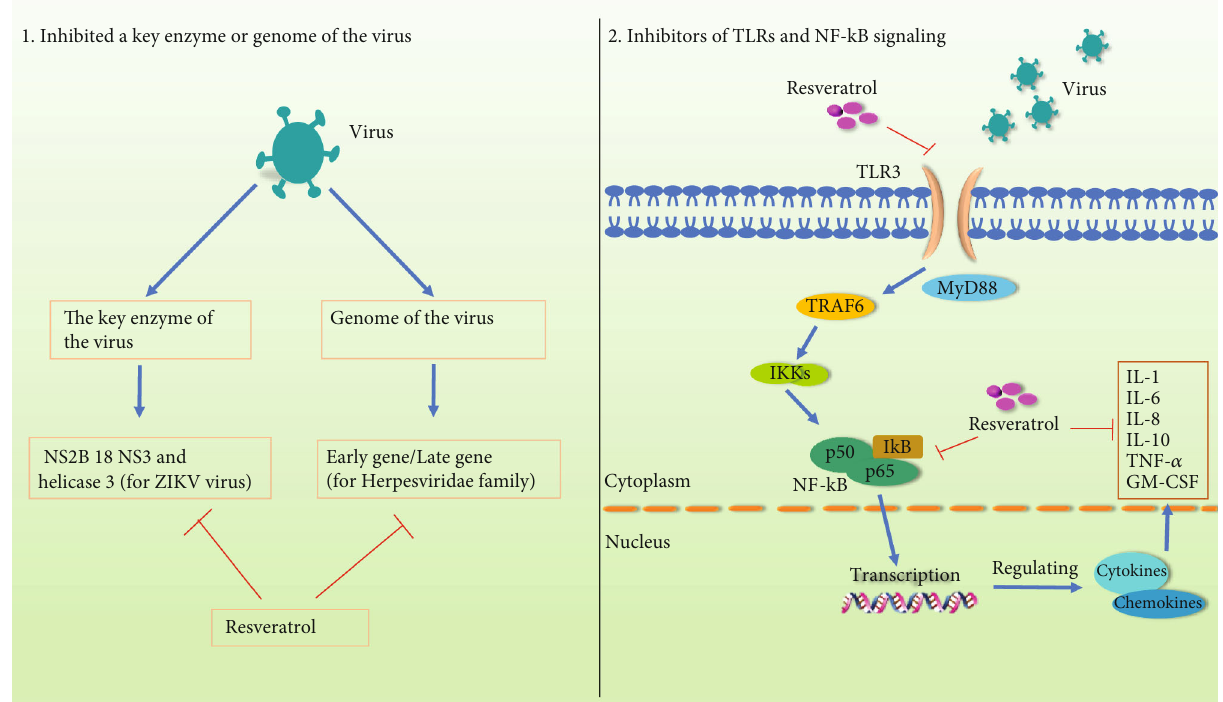
Figure 3: Schematic diagram of the possible mechanism by which resveratrol inhibits